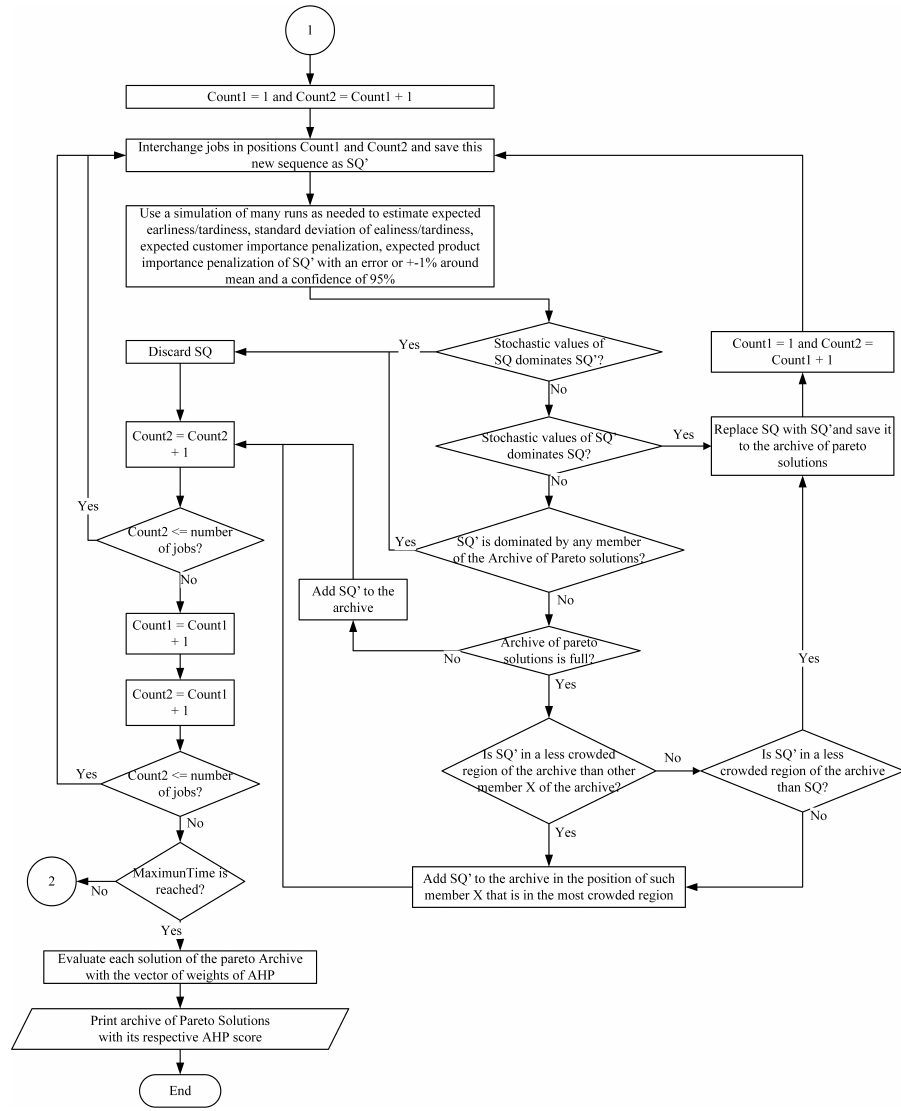
Figure 2. Flowchart of the GRASP local search